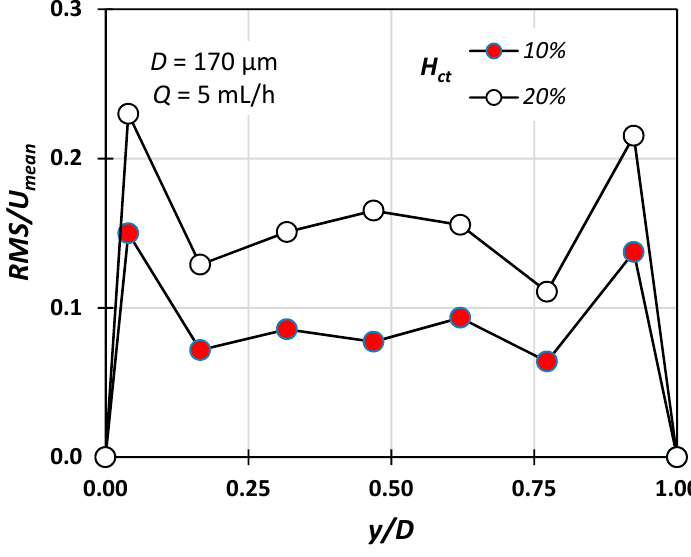
Figure 8. RMS / U mean variation for H ct = 10% and 20% with respect to the radial position ( Q = 5 mL / h, D = 170 μ m).